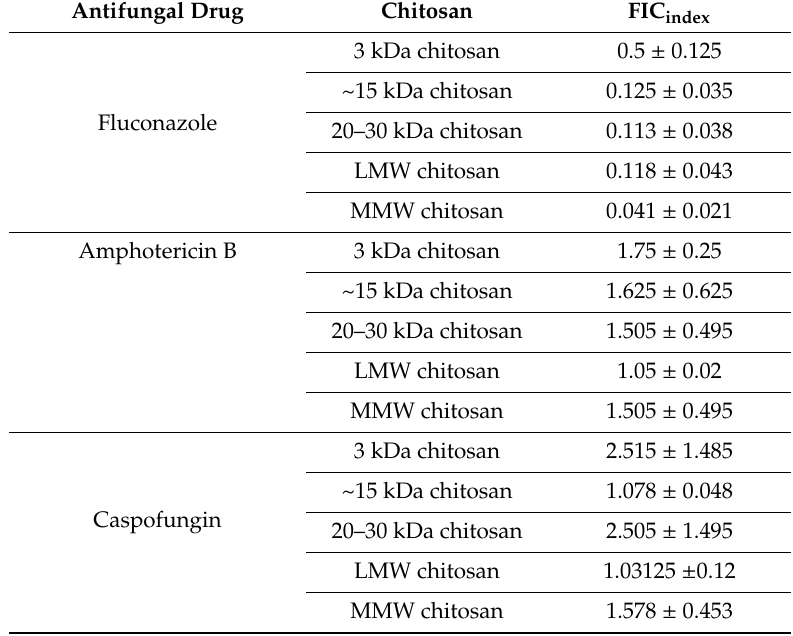
Table 2. Checkerboard assays of each chitosan in combination with an antifungal drug against C. albicans SC5314. FIC, fractional inhibitory